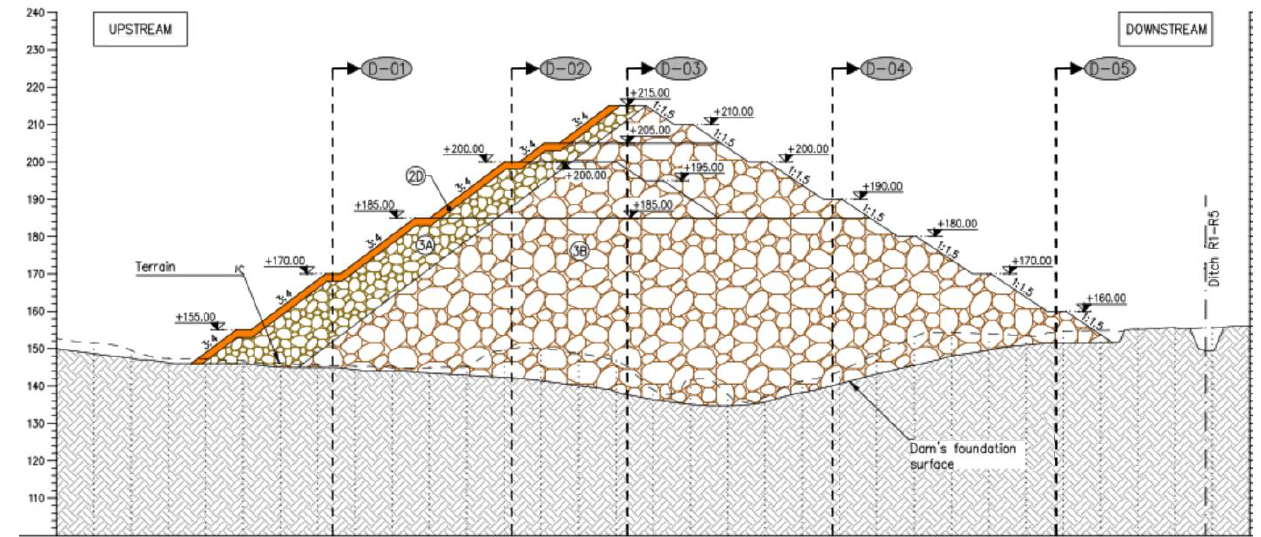
Figure 8. Downstream embankment engineering.